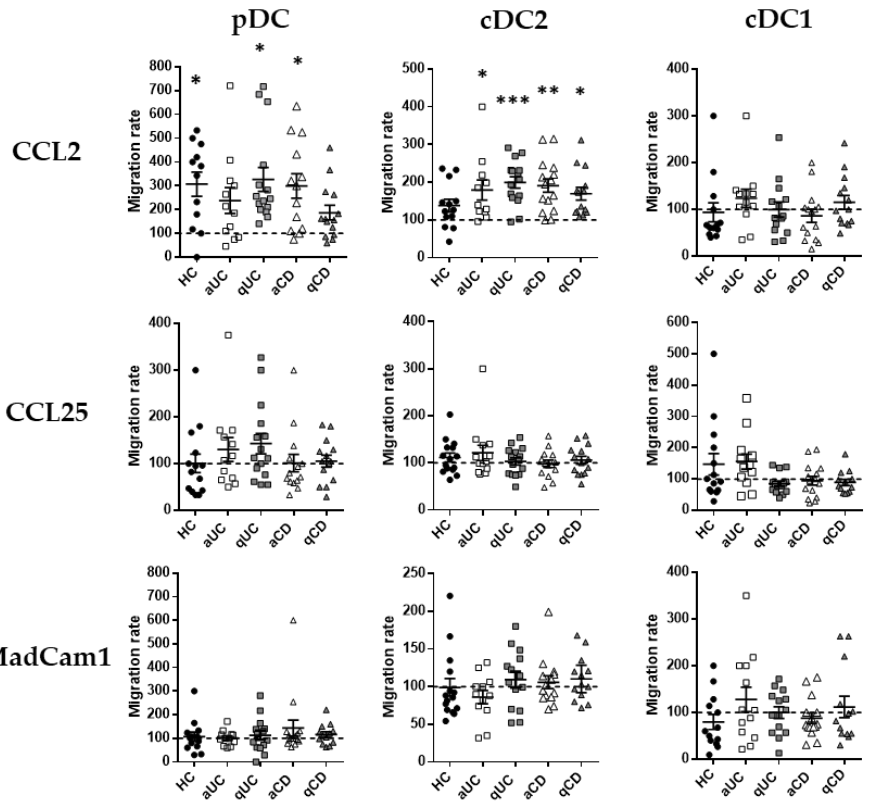
Figure 3. Dendritic cell subset migration towards CCL2 is increased in patients with inflammatory bowel disease. Peripheral blood mononuclear cells from healthy controls (HCs) and patients with active ulcerative colitis (aUC), quiescent ulcerative colitis (qUC), active Crohn’s disease (aCD) and quiescent Crohn’s disease (qCD) were allowed to migrate towards gut-homing chemo-attractants, including CCL2, CCL25 and MadCam1. Numbers of migrated DC subsets (pDCs, cDC2 and cDC1), as identified in Figure 1, were further determined. All results were relativized with respect to the spontaneous migration of the cells towards a non-supplemented culture medium (basal condition, dotted line) (mean ± SEM n = 15). One-way ANOVA with the Tukey correction was applied to compare with the basal condition. p -values < 0.05 were considered significant (* < 0.05, ** < 0.01, *** <